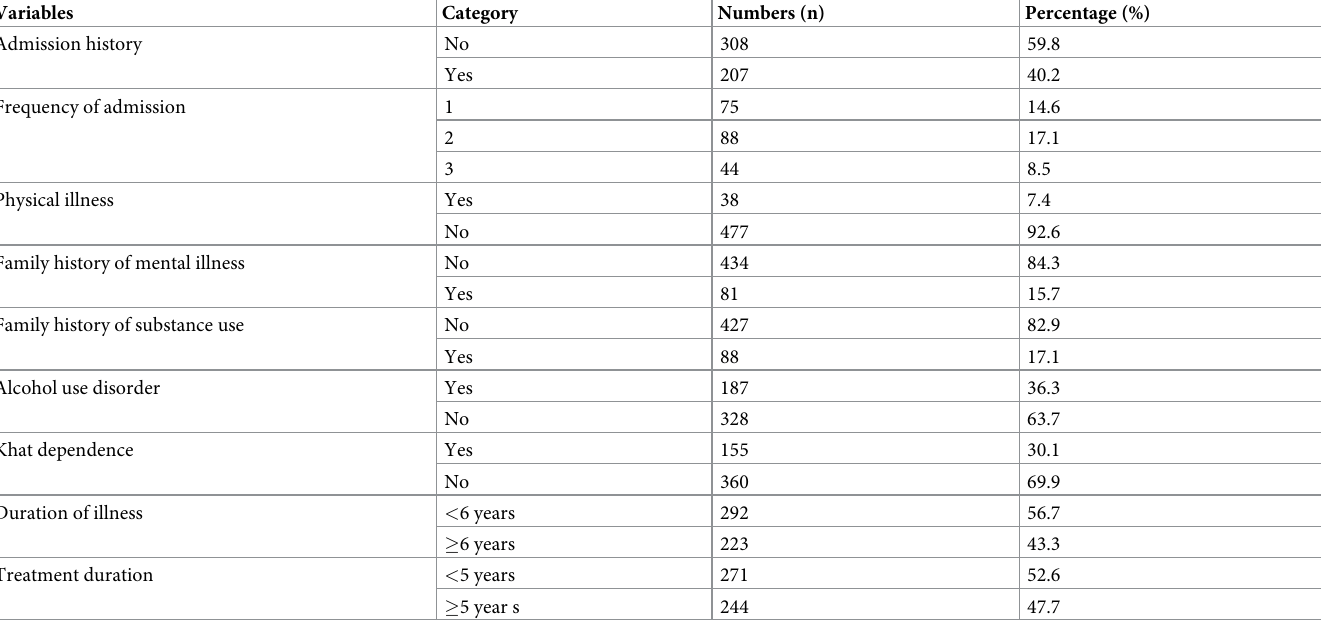
Table 2. Clinical and other substance-related characteristics of patients with schizophrenia, southwest Ethiopia, 2019 (n = 515).